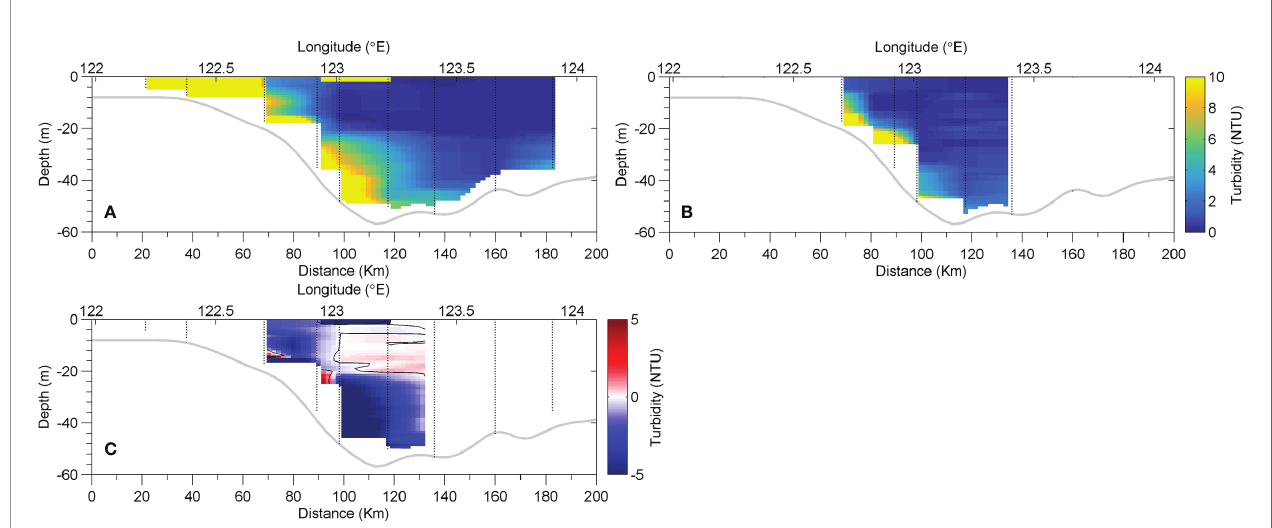
FIGURE 12 | Measured turbidity at the 31°N transect during Leg 1 (A) and Leg 2 (B) , respectively. (C) Difference in turbidity found by subtracting the pro fi les at the repeated sample stations (indicated by small black dots) conducted during Leg 1 from those during Leg 2 in the survey at the 31°N transect. Zero contour lines are plotted by thin black solid